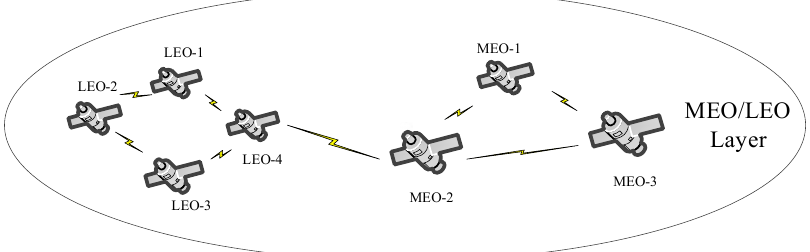
Figure 2. Composition structure of the nonsynchronous medium earth orbit/nonsynchronous low earth orbit (MEO/LEO) layer satellite system.